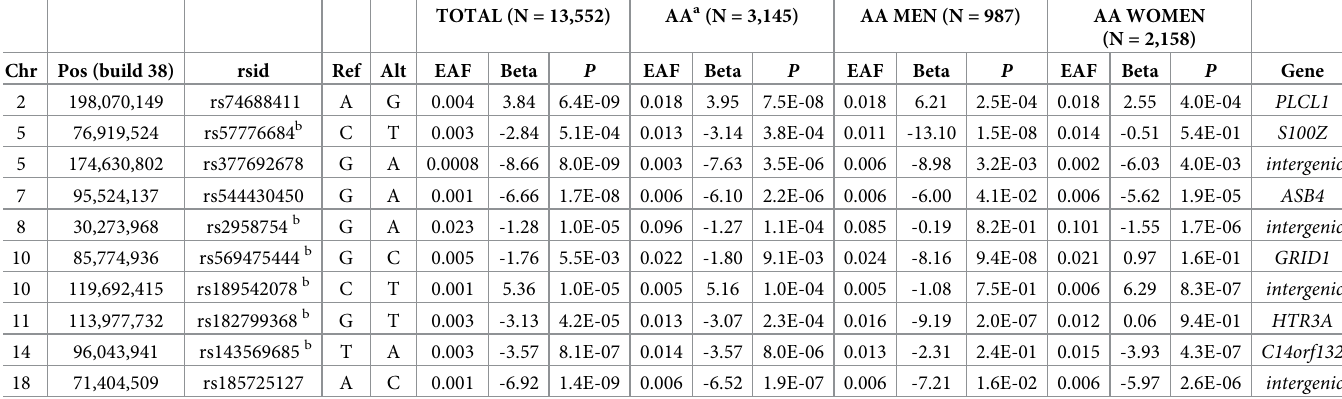
EAF: Effect allele Frequency; Alt: Alternate (Effect) allele; Pos: Positions in build GRCh38; Beta: effect size, unit (kg). a AA: Black/African American/African-ancestry participants.